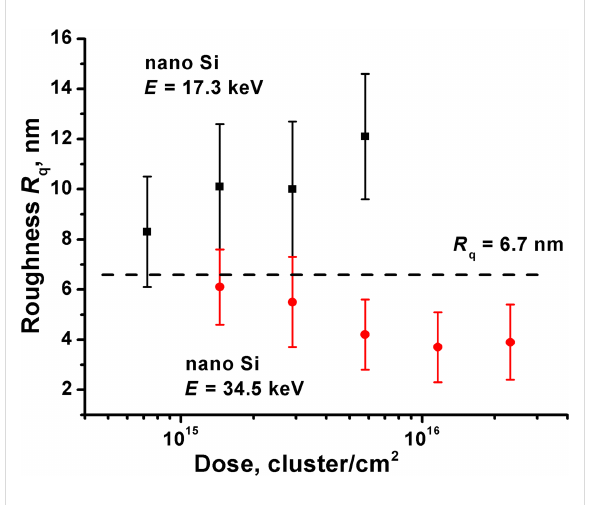
Figure 4: The roughness of the Si nanopowder versus the ion dose at different energies. The dashed line represents the initial roughness of the pressed